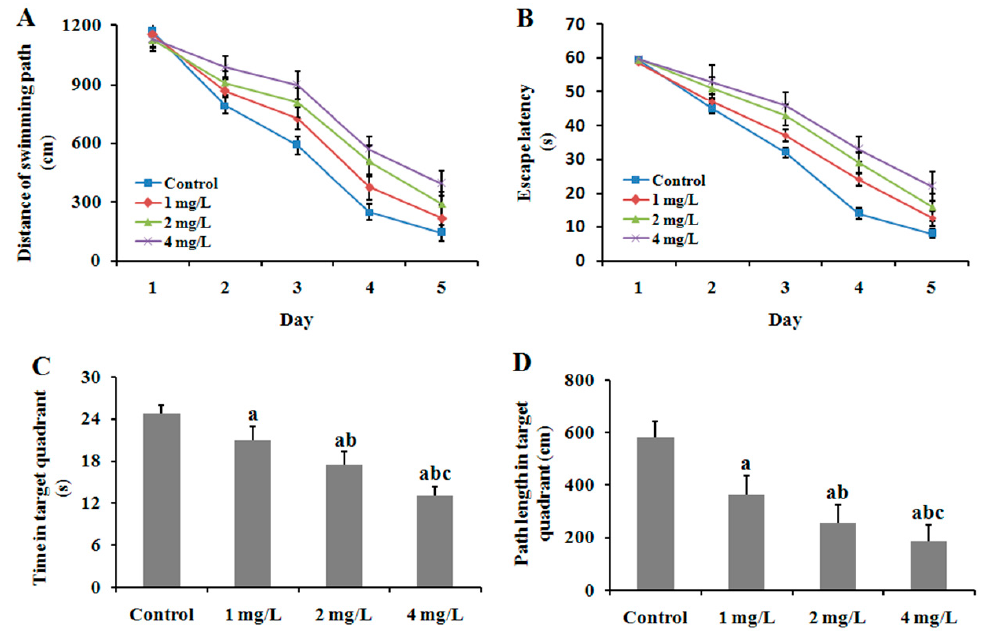
Figure 4. Effect of As exposure on learning and memory abilities of mice. Adult male mice exposed to 0, 1, 2, and 4 mg/L As 2 O 3 in drinking water for 60 days. After the treatment, the MWM tests were performed to analyze the learning and memory abilities of mice. Data obtained from twelve separate analyses are expressed as mean ± SD ( n = 12 for each group). ( A ) Distance of swimming path (cm) in the hidden platform test; ( B ) Escape latency to reach the platform (s) in the hidden platform test; ( C ) Time spent in target quadrant (s) in the probe test; ( D ) Path length in target quadrant (cm) in probe test. a p < 0.05 significantly different compared with the control group; b p < 0.05, significantly different compared with the 1 mg/L As 2 O 3 -treated group; c p < 0.05 significantly different compared with the 2 mg/L As 2 O 3 -treated group.